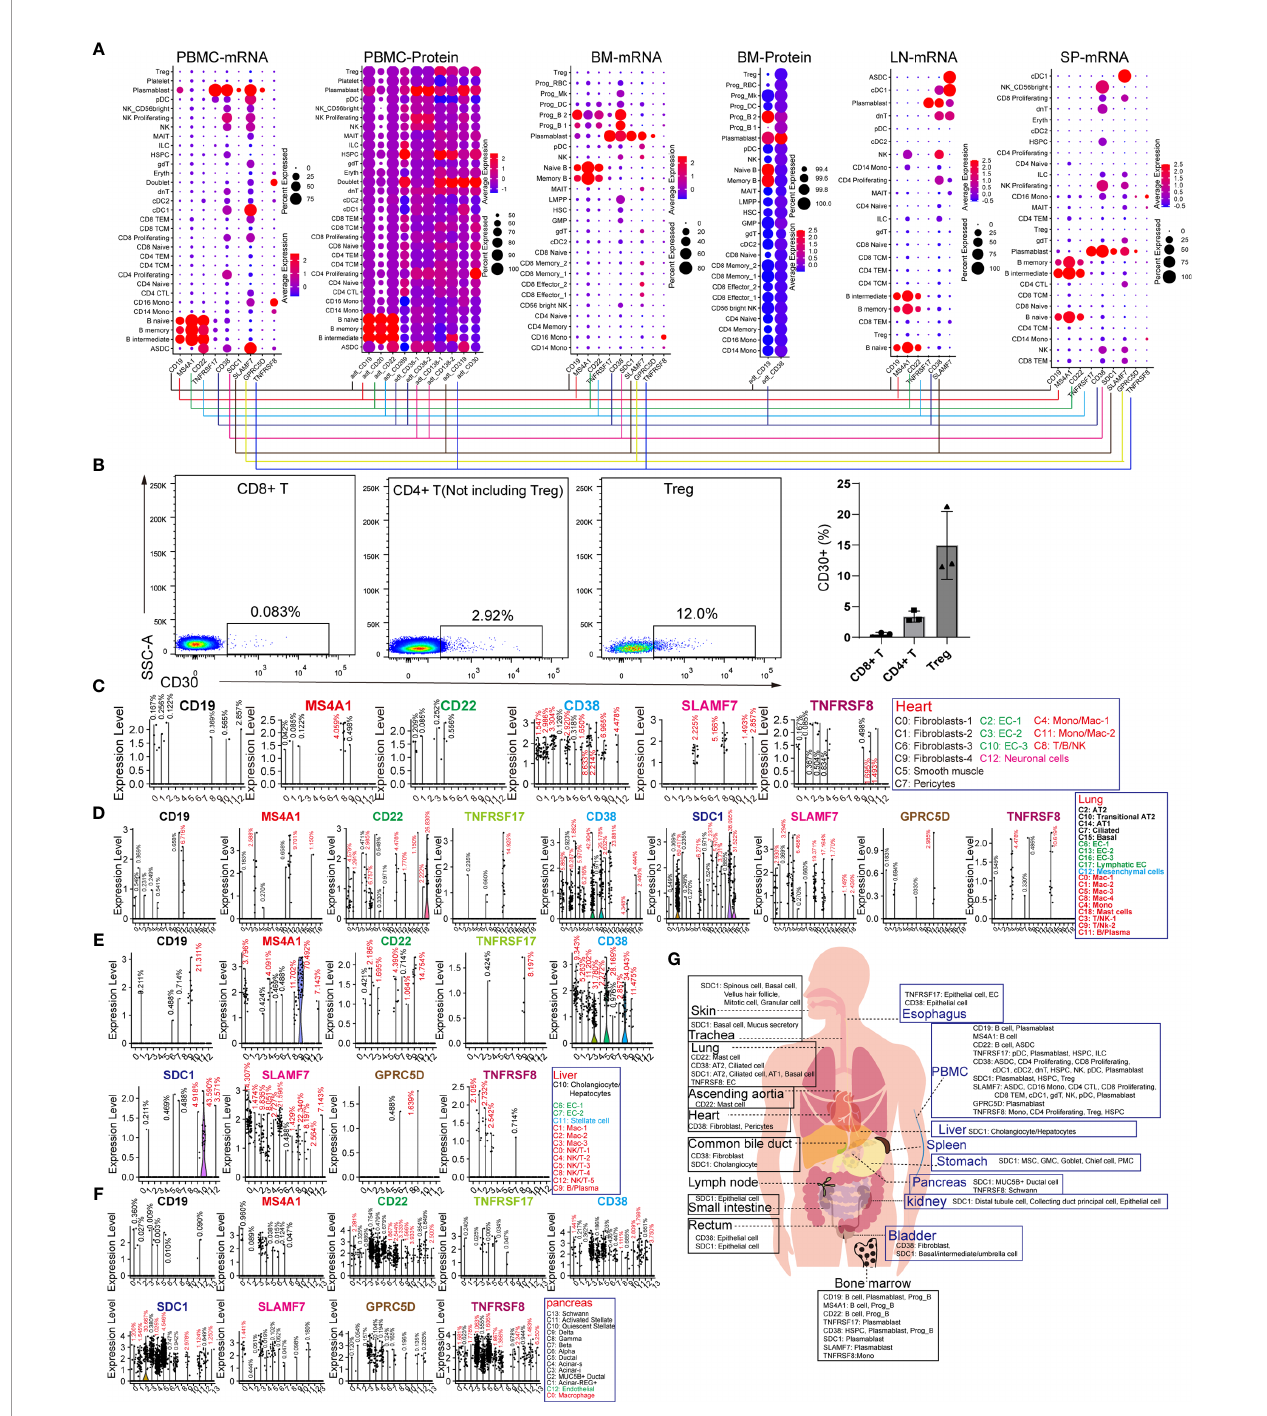
FIGURE 2 | Expression patterns of B-lineage-speci fi c antigens (CD19, MS4A1, CD22, TNFRSF17, CD38, SDC1, SLAMF7, GPRC5D, and TNFRSF8) in human normal tissues and organs. (A) Dot plots show the expression levels of B-lineage-speci fi c antigens in PBMCs, BM, LN, and SP at mRNA level or protein level. (B) Flow cytometric analysis of abandoned human PBMCs after medical examination. Representative FACS dot plots for CD30 in normal CD8 + T cells (DAPI − CD4 − CD8 + ), CD4 + T cells (DAPI − CD4 + CD8 − but excluding Treg), and Treg cells (DAPI − CD4 + CD8 − CD127 low/ − CD25 + ). Frequency histogram of CD30+ cells in CD8 + T cells, CD4 + T cells, and Treg cells. Violin plots show the expression level of B-lineage-speci fi c antigens in heart-derived clusters (C) , lung-derived clusters (D) , liver-derived clusters (E) , and pancreas-derived clusters (F) . (G) Schematic diagram of high B-lineage-speci fi c antigen-expressing cell types in different tissues and